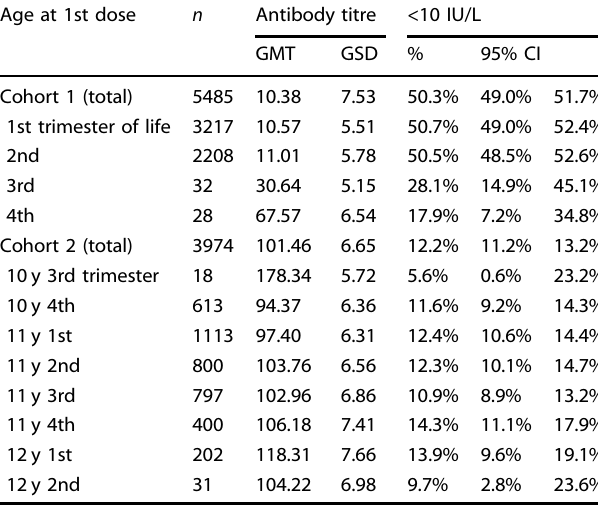
Table 2. Long-term anti-HBs titre and proportion of individuals below 10 IU/l by age at the fi rst dose vaccine administration. Age at 1st dose